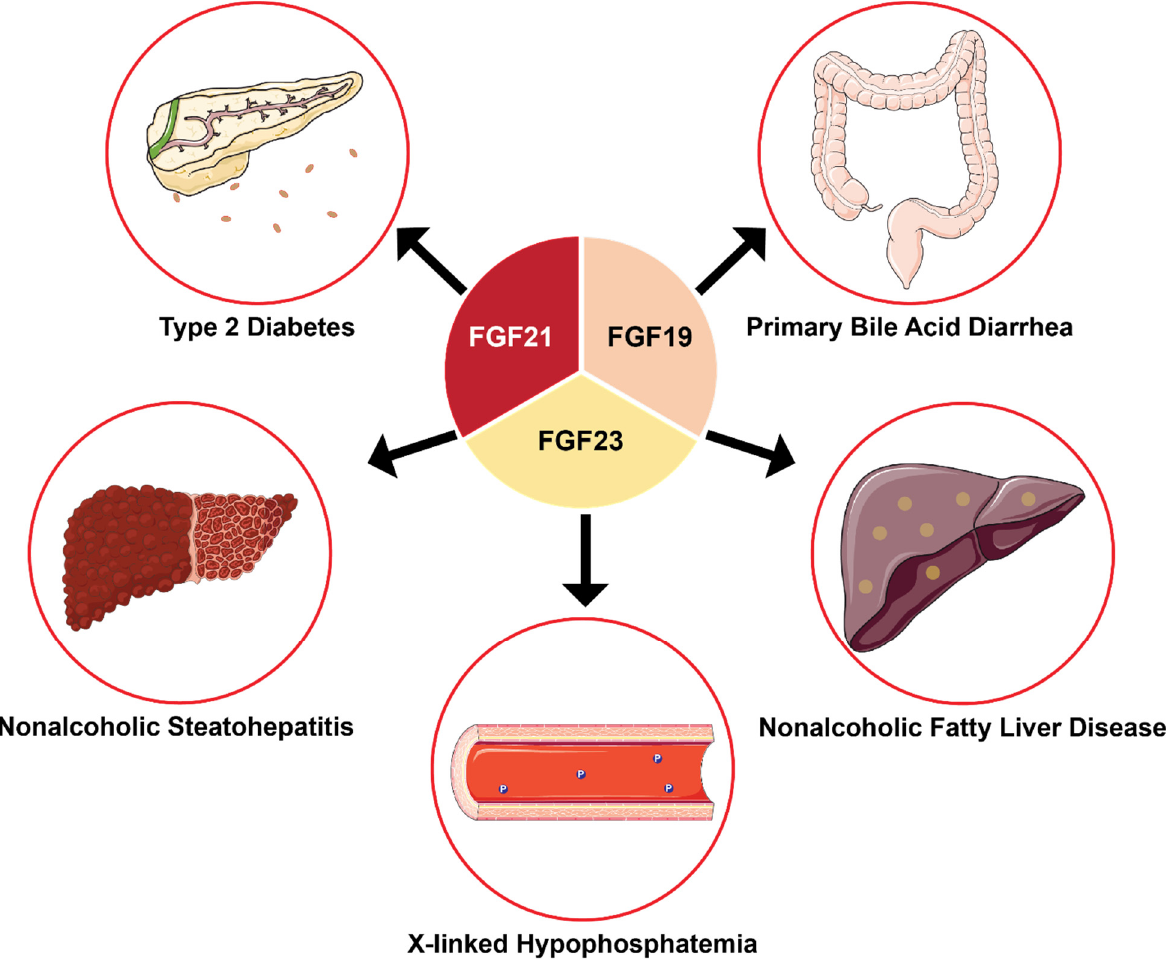
Figure 8. Biomedical applications of endocrine FGFs that target specific human diseases and conditions. Current biomedical and clinical applications of endocrine FGFs focus on treating various diseases. Many of these applications have advanced to Phase I or II of clinical trials and show optimistic results.